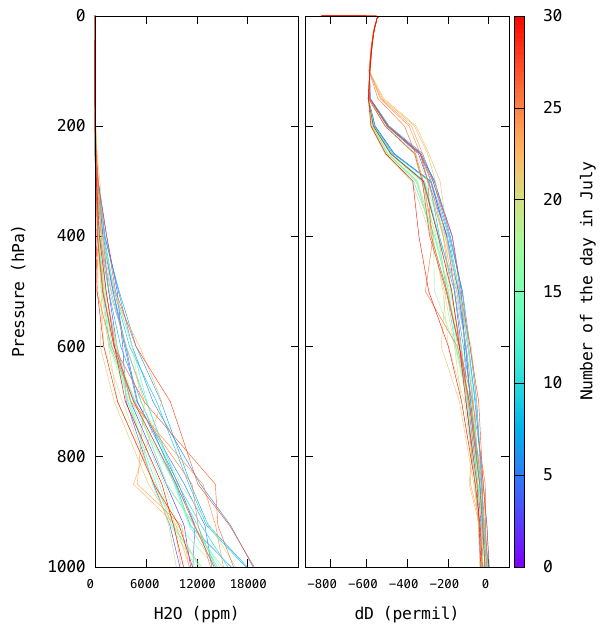
Figure 9. H 2 O and corresponding δ D a priori profiles derived from NCEP/NCAR reanalysis data using Eq. (1).